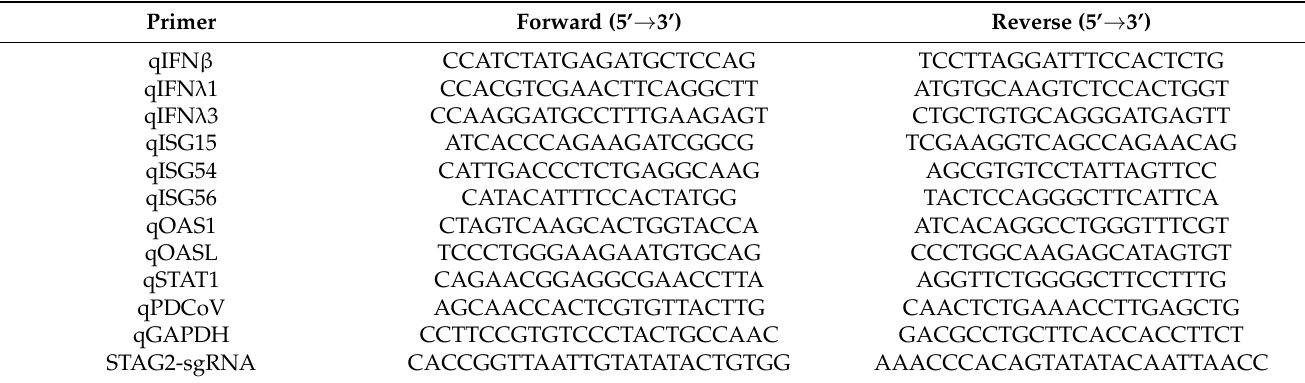
Table 1. Primers used in this